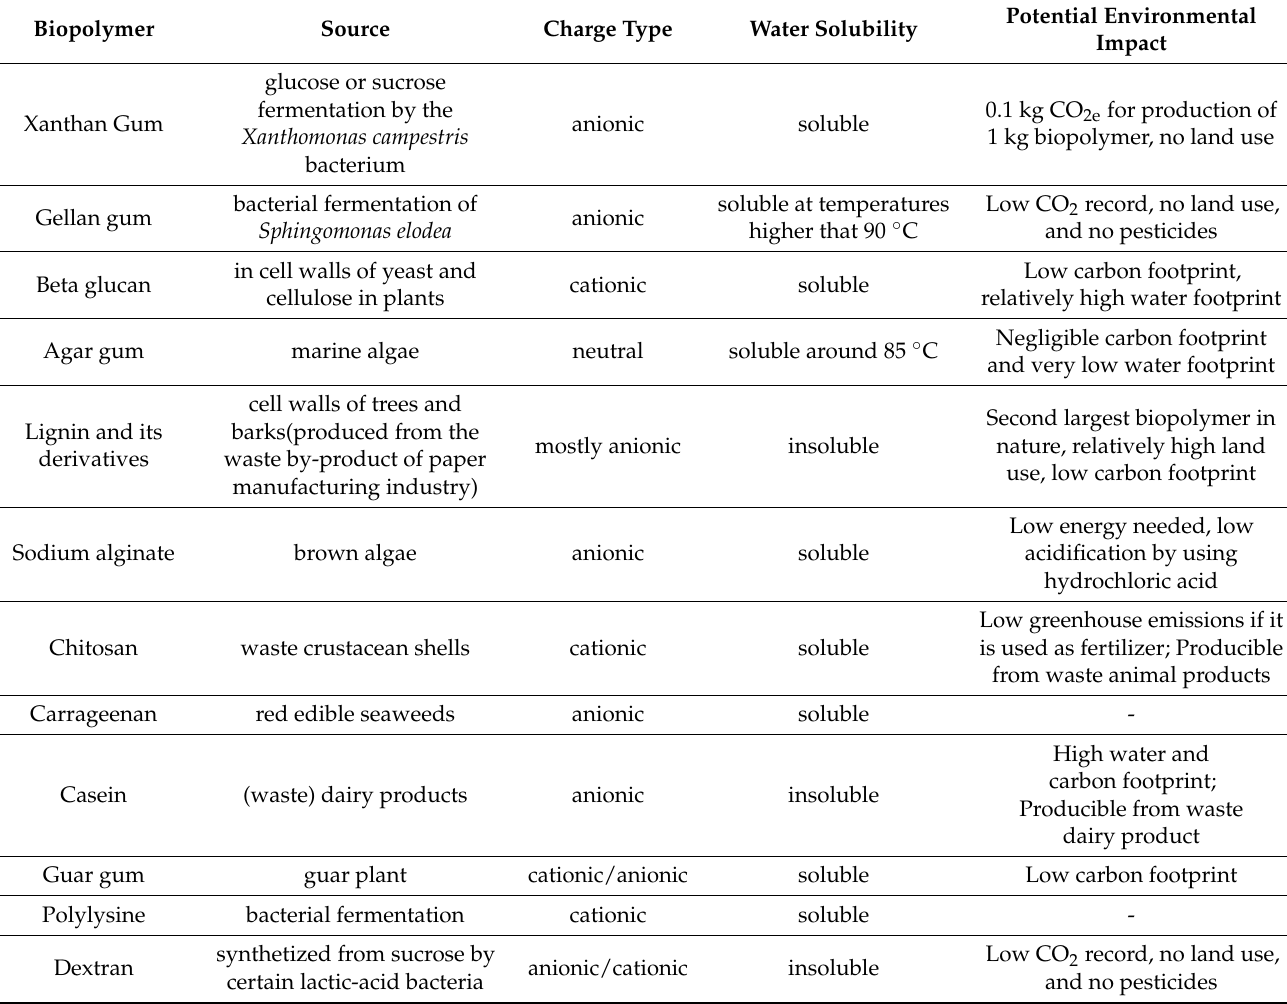
Table 1. Characteristics of common biopolymers utilized for soil treatment and their potential environmental impacts.